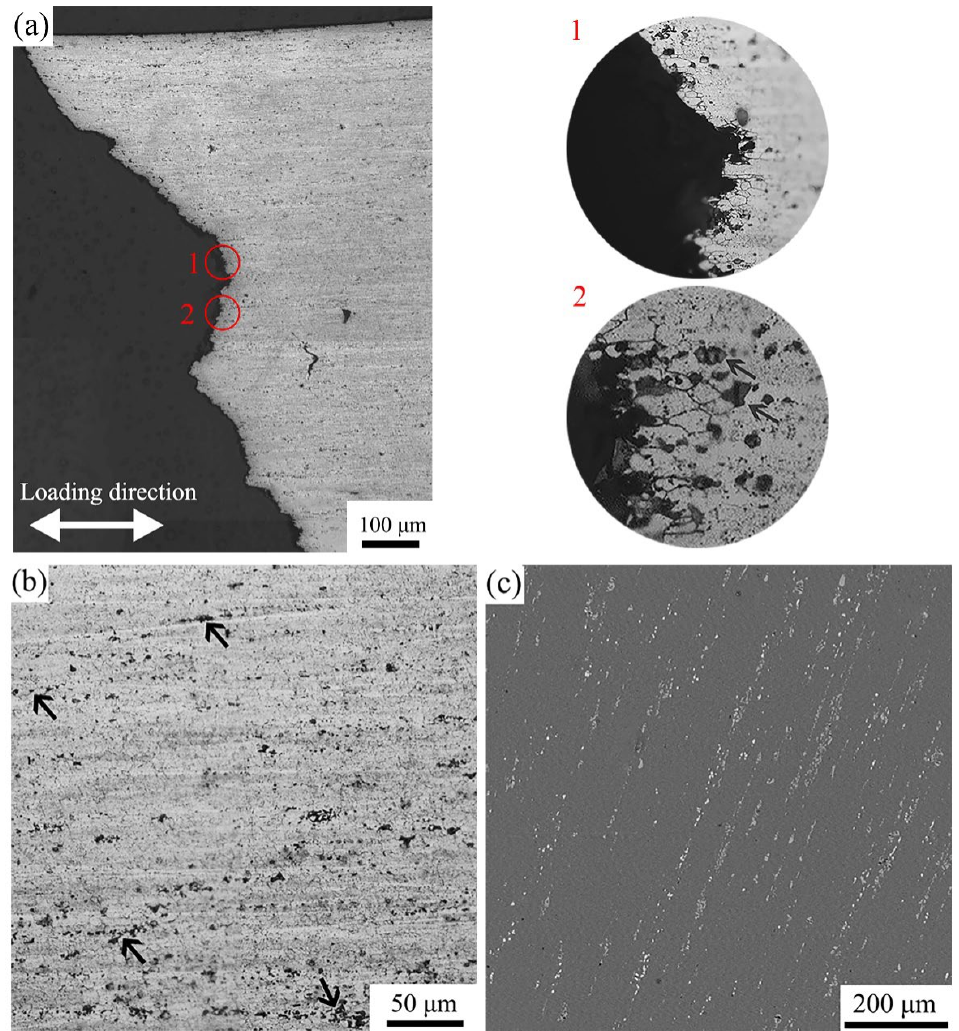
Figure 3. Morphology and microstructure of the longitudinal fracture section, where ( a , b ) are the OM micrograph, and ( c ) shows the SEM micrograph. (Observation positions 1 and 2 in Figure ( a ) at high magnification, the arrows refer to the second phase in the